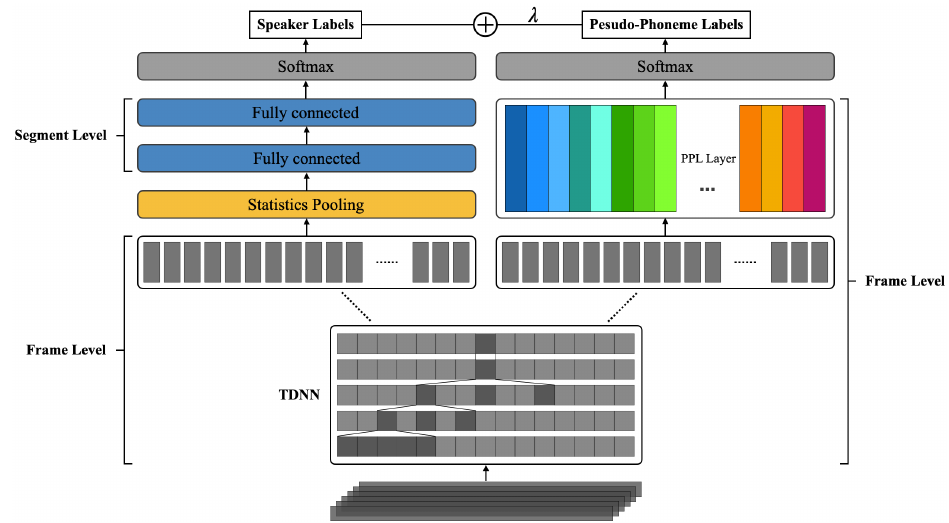
Figure 1. The x-vector architecture for speaker recognition. Using joint learning, the frame-level information from the TDNN layer is compared with the center vector in the PPL layer to calculate the PPL loss, which is then summed with the CE loss to obtain the total loss.